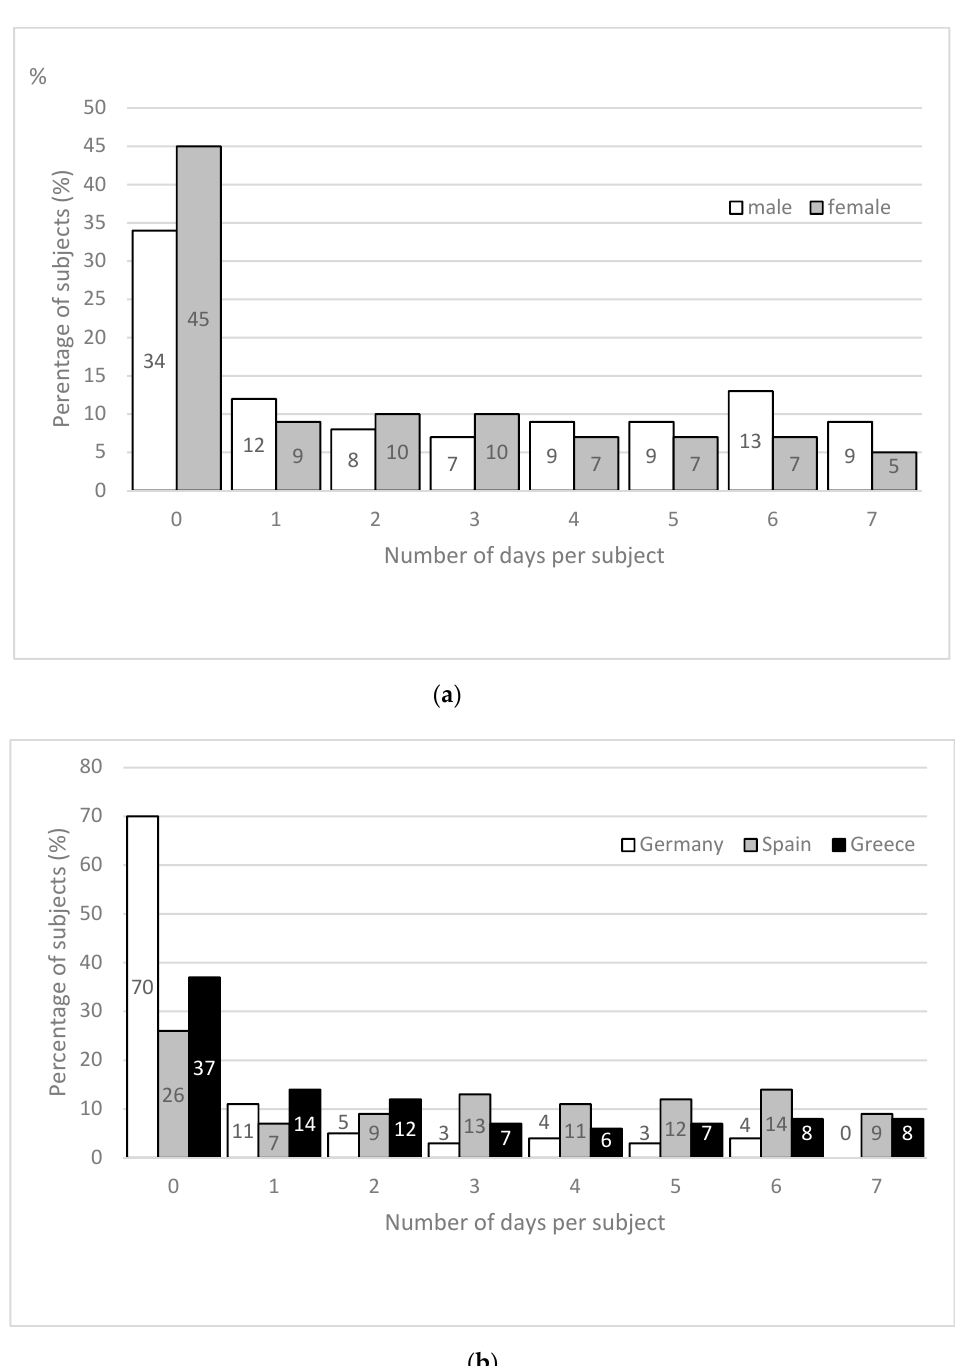
Figure 3. ( a ) Number of days per subject in the seven-day study period with a 24 h urine osmolality >800 mOsmol/kg for men and women; ( b ) number of days per subject in the seven-day study period with a 24 h urine osmolality >800 mOsmol/kg with respect to the country.